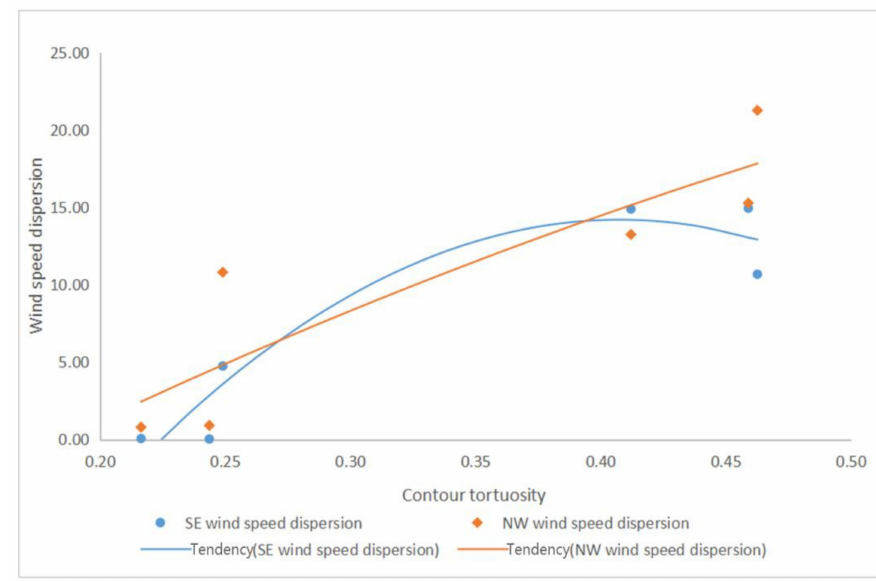
Figure 20. The relationship between wind speed dispersion and contour